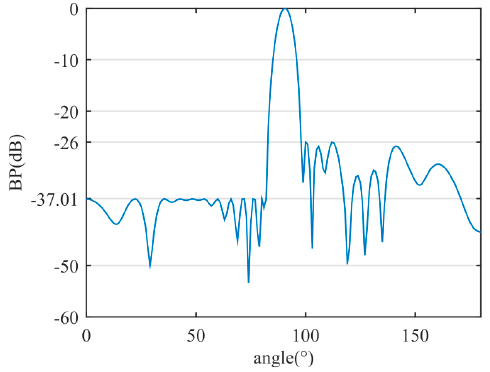
Figure 12. The asymmetric sidelobe BP of the sparse linear array.